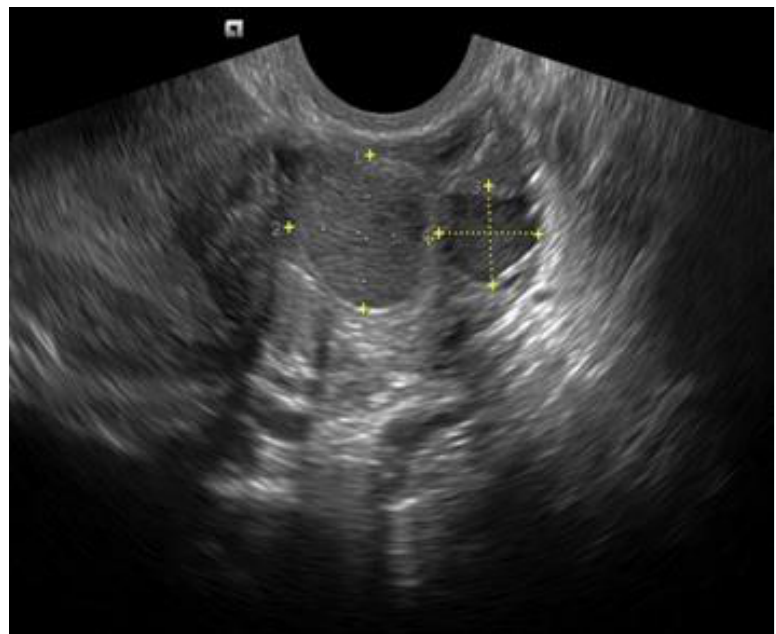
Figure 2. Two small OMAs with typical appearance in the same ovary.